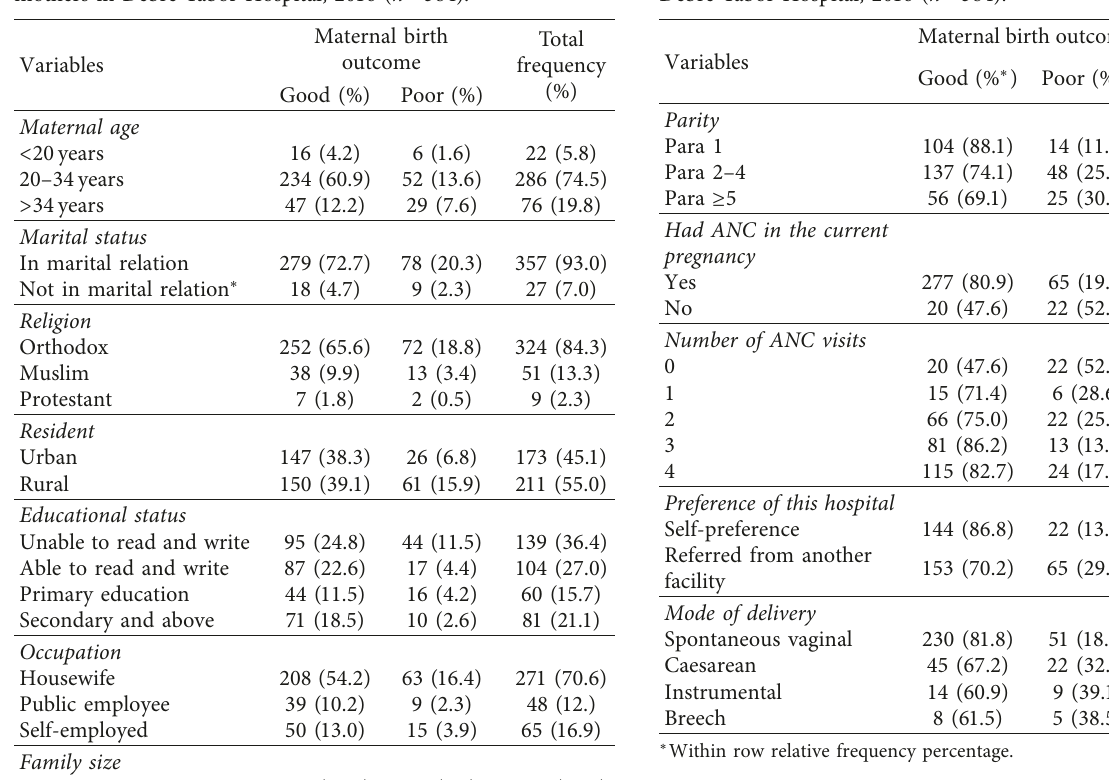
Table 1: Frequency distribution of sociodemographic variables cross tabulated with maternal birth outcome, among postnatal mothers in Debre Tabor Hospital, 2016 ( n � 384).